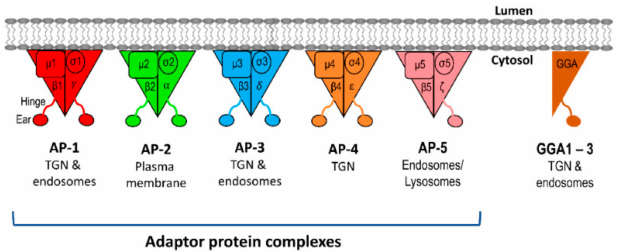
Figure 4. Cargo adaptor proteins: Five adaptor protein (AP) complexes, AP-1 (red), AP-2 (green), AP-3 (blue), AP-4 (orange), and AP-5 (pink), have been identified to date in higher eukaryotes. Each heterotetrameric AP complex comprises two ~100 kDa large subunits ( β 1–5, and either α , γ , δ , ε , or ζ ), one ~50 kDa medium subunit ( µ 1–5), and one ~20 kDa small subunit ( σ 1–5). Together, they form the AP core, which is